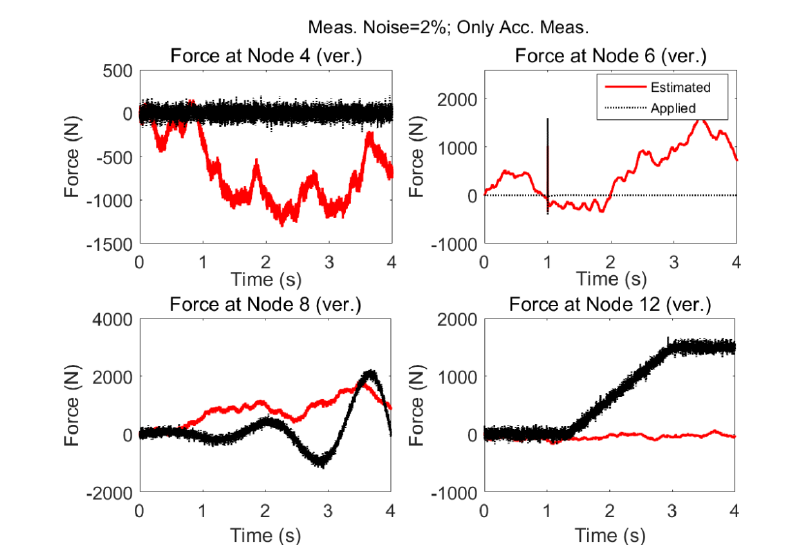
Figure 13. Same as Case 2 but there is modeling error (5%) and measurement noise (2%). 3.3. Case 3: Only Strains Are Measured—Modeling Error (5%) and Measurement Noise (2%)